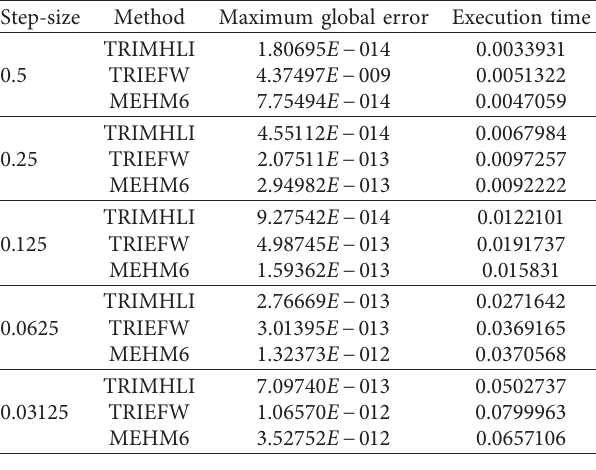
Figure 1: Region of absolute stability of method MEHM6. Table 1: Numerical results for Problem